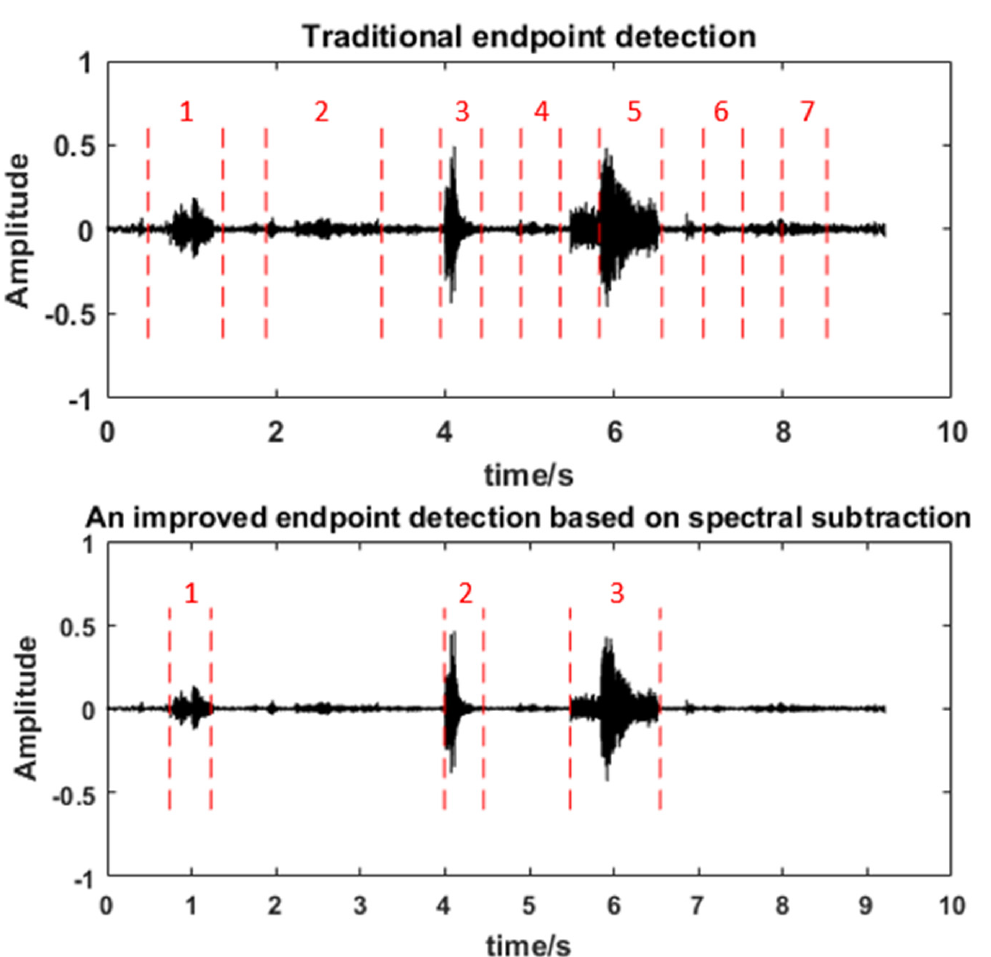
Figure 8. The validity of endpoint detection used in the